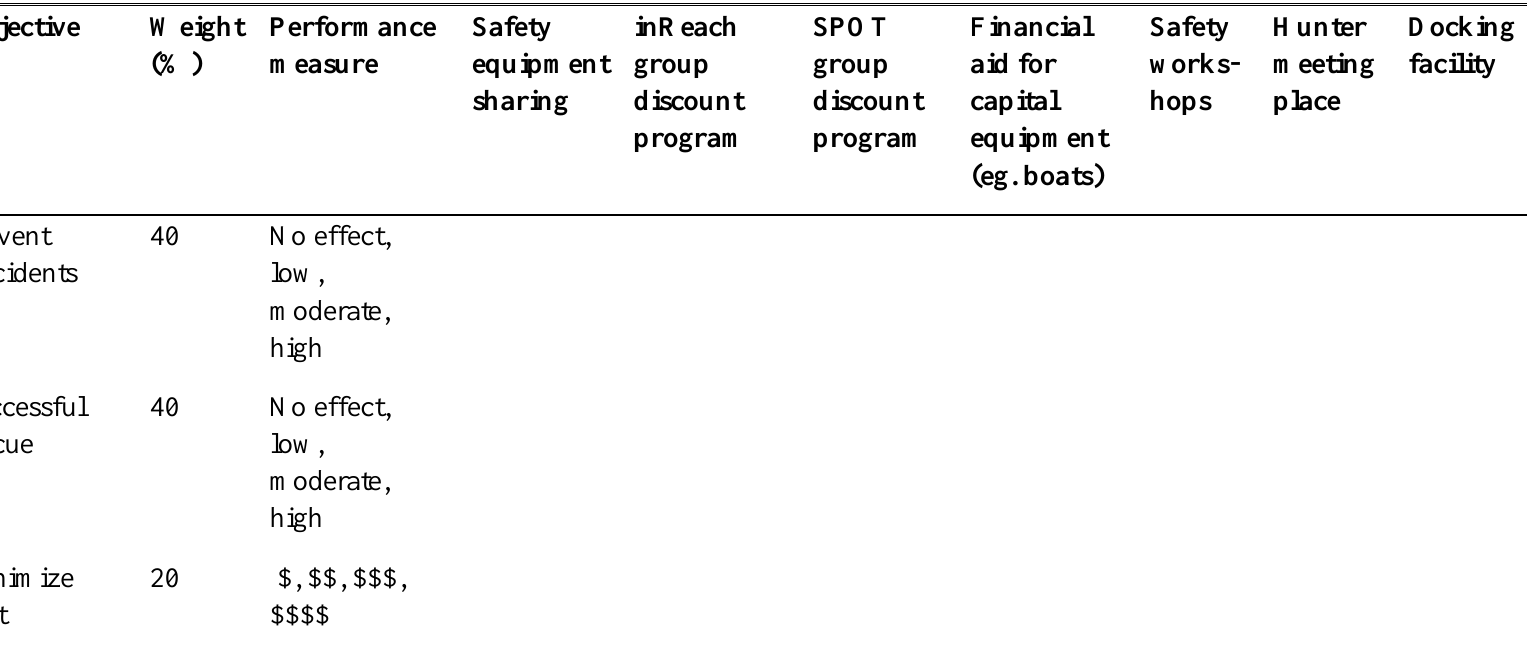
Table A1.1. Structured Decision Analysis consequence table for hunter safety strategies. Participants evaluated each strategy based on its ability to meet the objectives. This consequence table was completed by the group during workshop